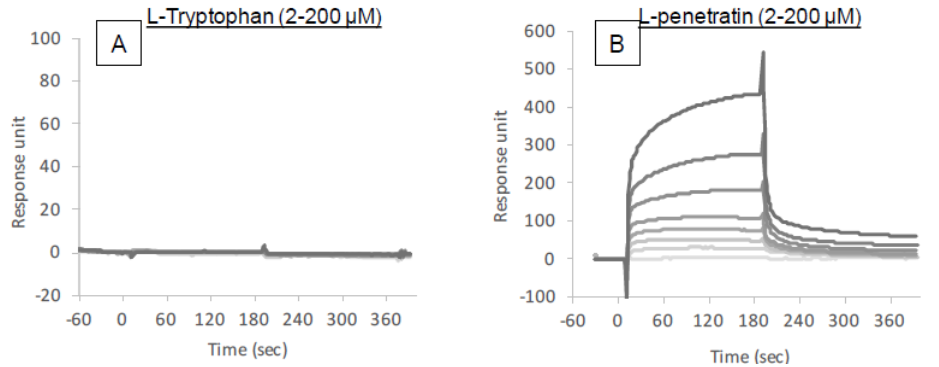
Figure 7. Binding sensorgrams obtained by SPR analysis. Various concentrations of L -tryptophan ( A ) or L -penetratin ( B ) solutions (pH 7.4) were injected into insulin-immobilized flow cells.